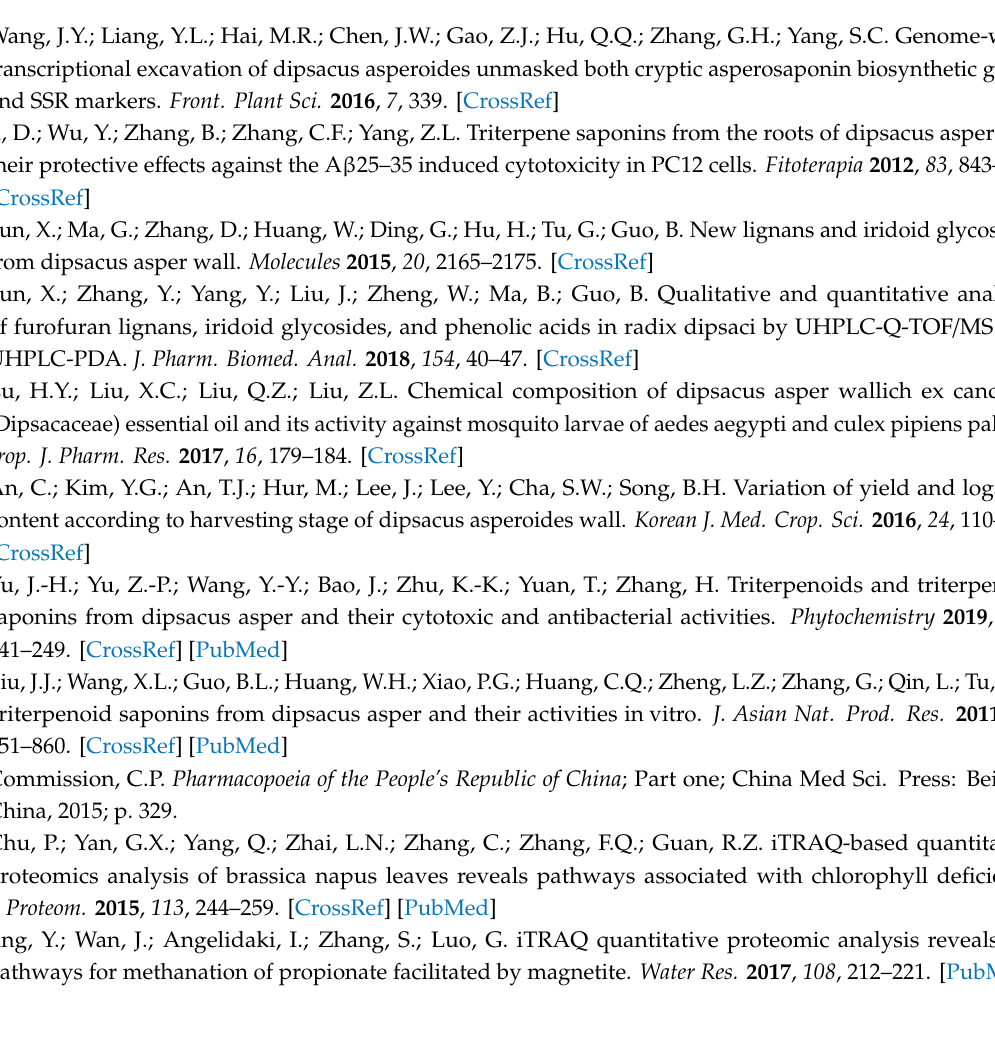
Supplementary Materials: The following are available online. Table S1: Raw data of identification and analysis of the Dipsacus asperoides proteome; Table S2: Information on 202 screened di ff erentially expressed proteins. Table S3: String protein